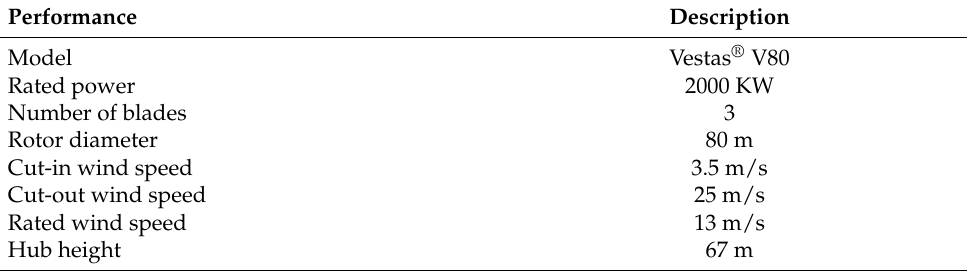
Table 2. Parameters of the wind